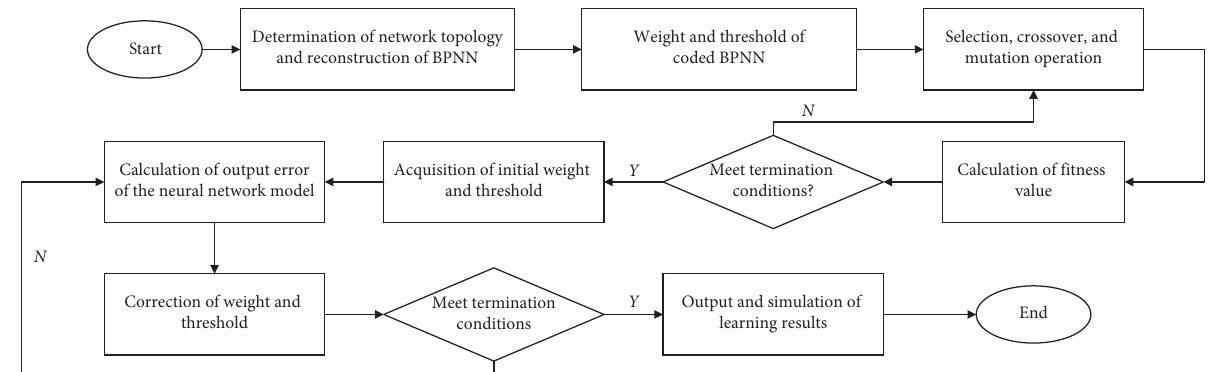
Figure 2: The specific implementation process of optimized BPNN.